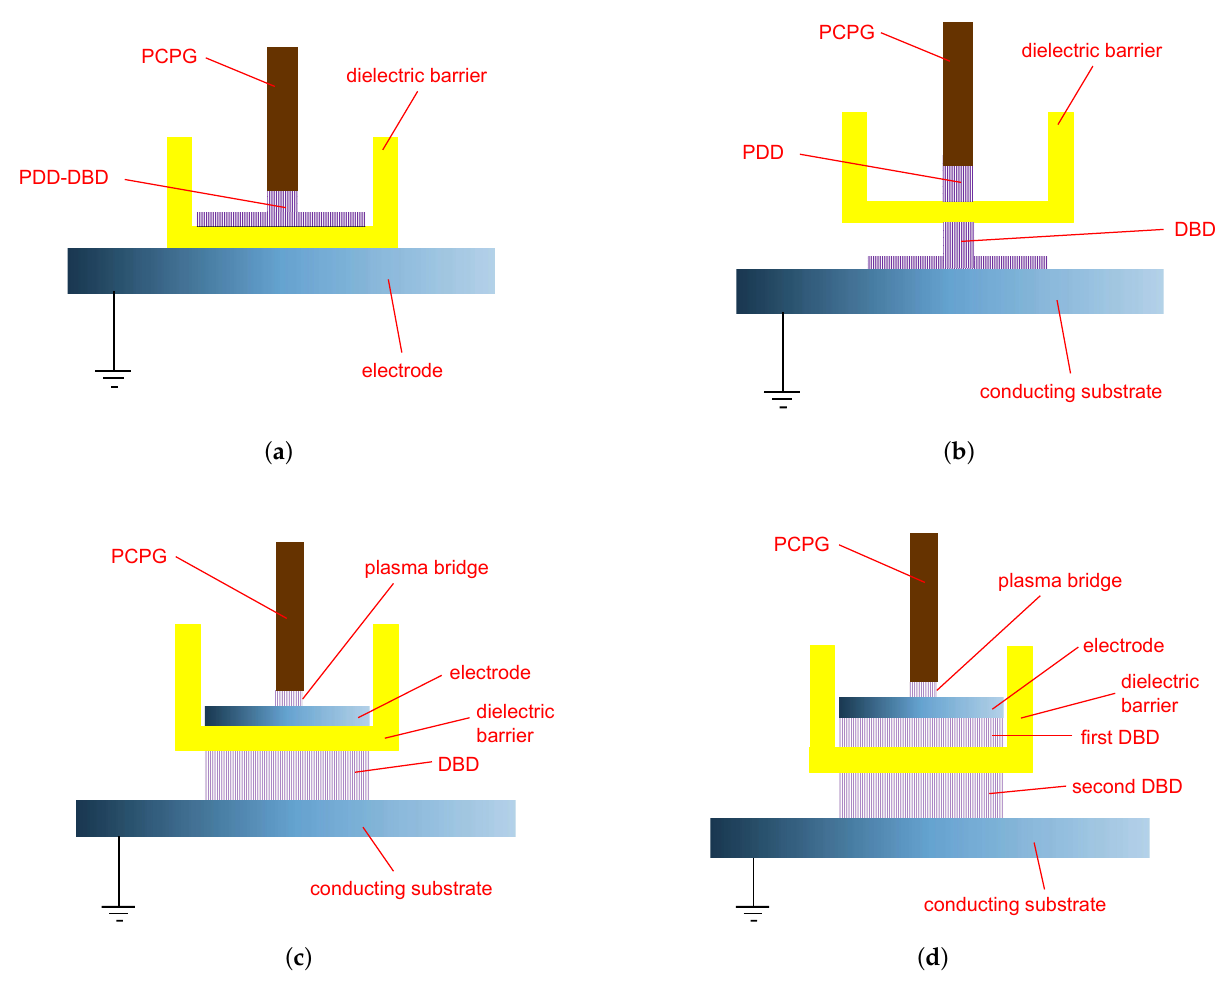
Figure 11. Four configurations of the PDD driven DBD. ( a ) the PCPG as the DBD electrode in a single DBD, ( b ) the PCPG as the DBD electrode in a double DBD, ( c ) the excitation electrode powered by PCPG over the plasma bridge and the single DBD, and ( d ) the excitation electrode powered by PCPG over the plasma bridge and the double